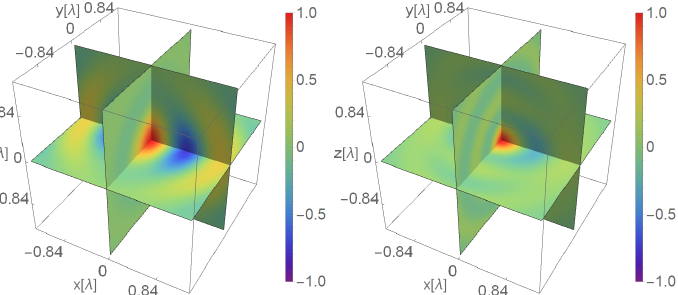
Figure 14. Left : seismic correlations between the origin and all the other points in the presence of a homogeneous and isotropic seismic field composed only of P-waves. Right : seismic correlations between the origin and all the other points in the presence of a homogeneous and isotropic seismic field composed of 1/3 of P-waves and 2/3 of S-waves (assuming an equal distribution of energy between the three polarizations: one for P-waves and two for S-waves). Figure taken from